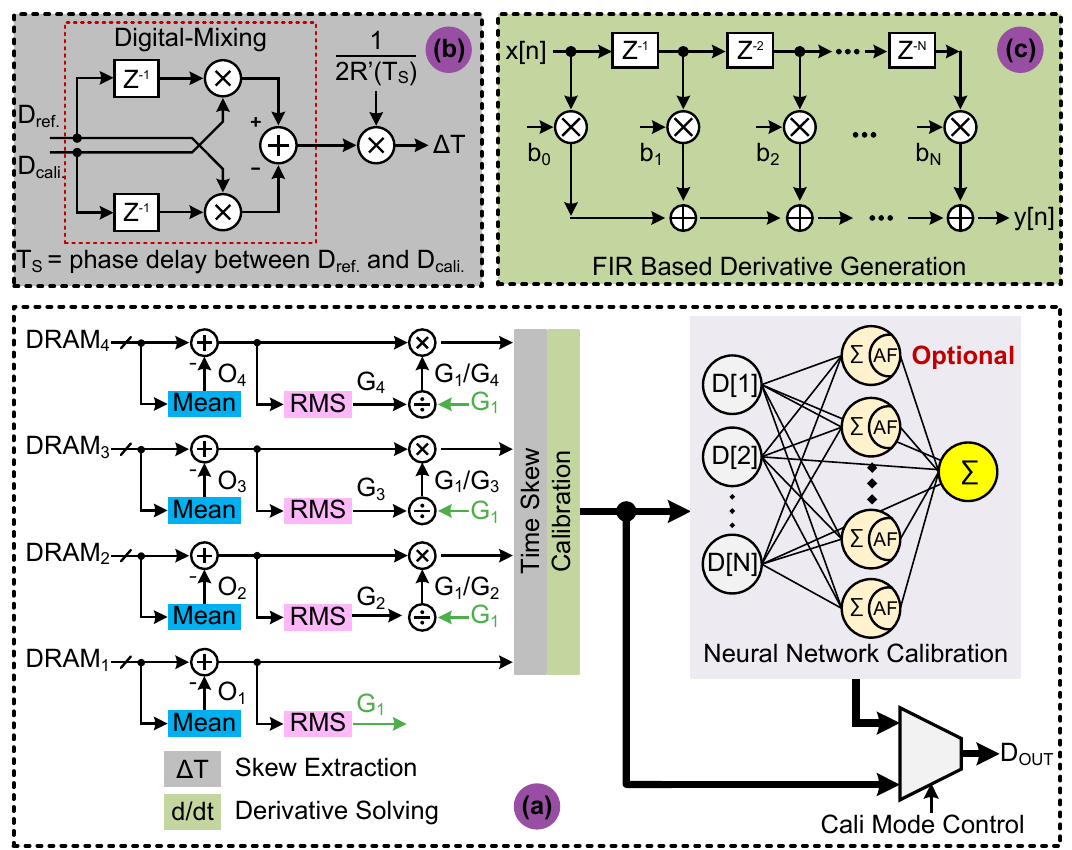
Figure 9. Digital background calibration for offset, gain, and timing mismatch: ( a ) The complete TI mismatches calibration with NNC optional; ( b ) Skew extraction based on digital-mixing; ( c ) Derivative solving based on FIR